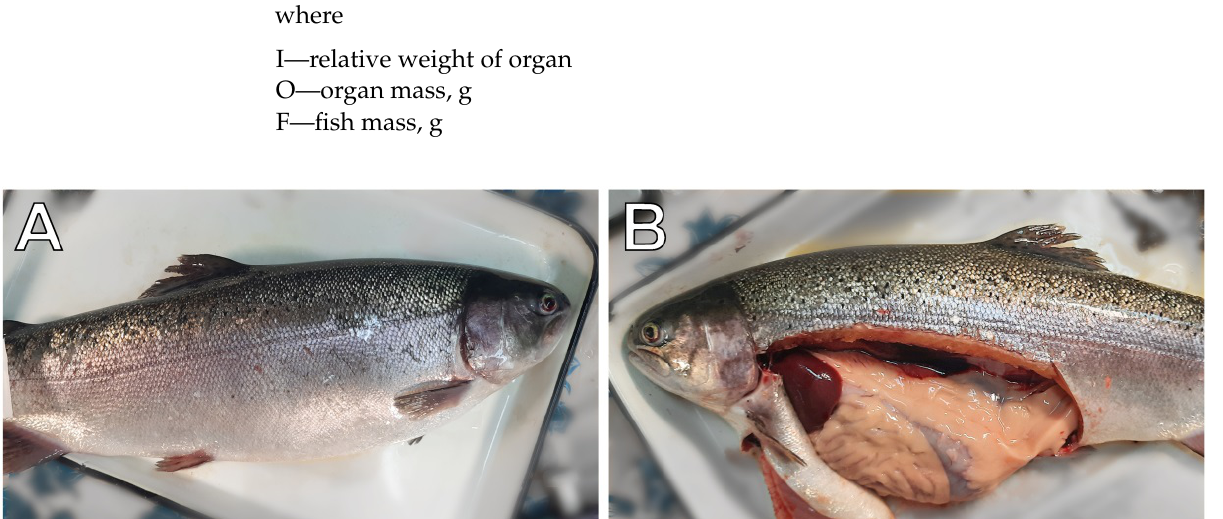
Figure 1. Representative anomalies of rainbow trout collected from a fish farm during a vibriosis outbreak with varying degrees of infection. ( A )—asymptomatic fish with insignificant signs of dis- ease on the skin and fins (AS group). ( B )—dissection of asymptomatic fish with no hemorrhages in the body cavity (AS group). ( C )—fish with “red marks” on the skin (white arrows) indicating infec- tion (IP group). ( D )—local hemorrhages (white arrow) in the liver of an infected trout (IP group). ( E )—blisters (black arrow) and complete eye loss (white arrow) in fish with severe skin lesions and ulcers (SL group). ( F )—hemorrhagic foci (white arrow) in the liver of severely affected fish (SL group). The 10 L (total) water samples near the water surface at a distance of one meter from the cage were collected by using two sterile glass bottles (5 L × 2) and immediately filtered through a sterile 0.22 μm filter cartridge. The filter was transferred in a cryovial, frozen, and stored in liquid nitrogen until DNA extraction. 2.2. Fish Pathology Characterization (Diagnostic Criteria) To rank fish ( n = 19) welfare according to the severity of the infectious process, a semi- quantitative scoring system was used. For this, each observed pathological change in skin, gills, liver, spleen, muscles, kidney, gastrointestinal tract, etc., of an individual fish was assigned points of ichthyopathology (1 point corresponded to the normal state, 2 points to weak pathology, and 3 points to severe pathology). The obtained points were summed up, and an integral score of ichthyopathology (IPS) was obtained for each fish (Table S1.3).